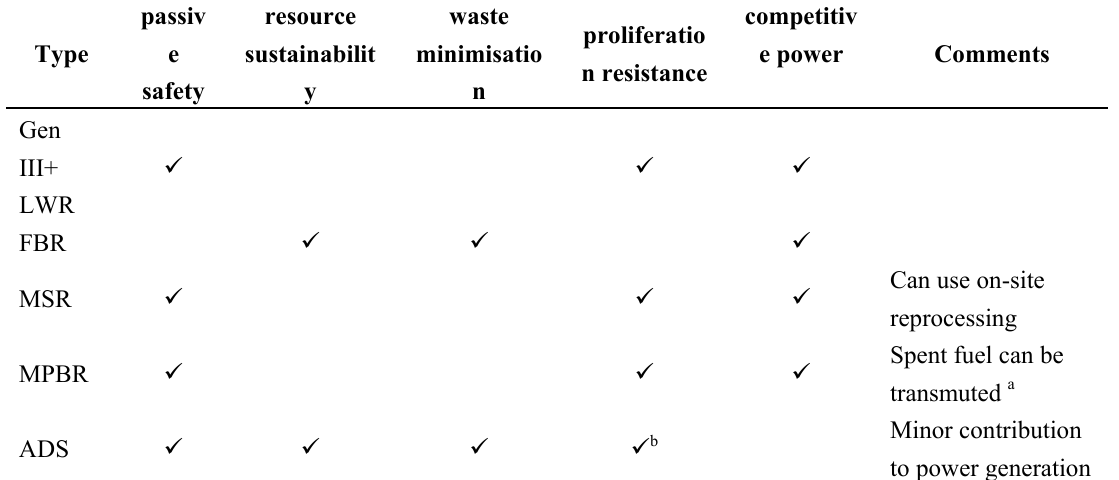
Table 3. Summary criteria for advanced nuclear